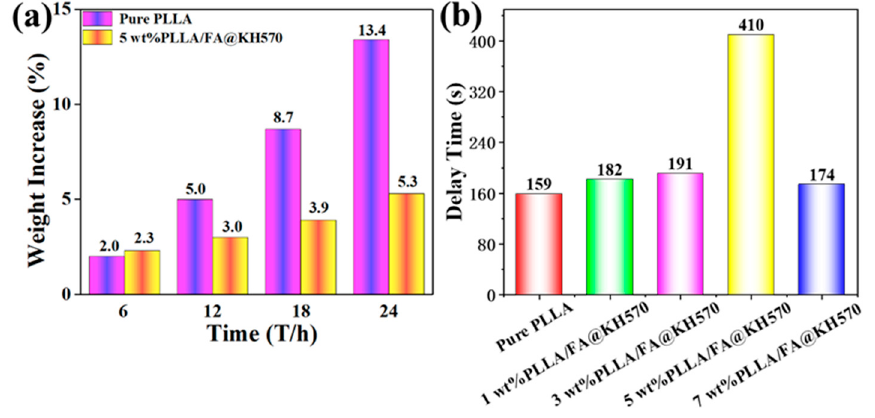
Figure 8. ( a ) Weight increase of pure PLLA and 5 wt% PLLA/FA@KH570 composite. ( b ) Delay times of neat PLLA and PLLA/FA@KH570 composites during the icing procedure.